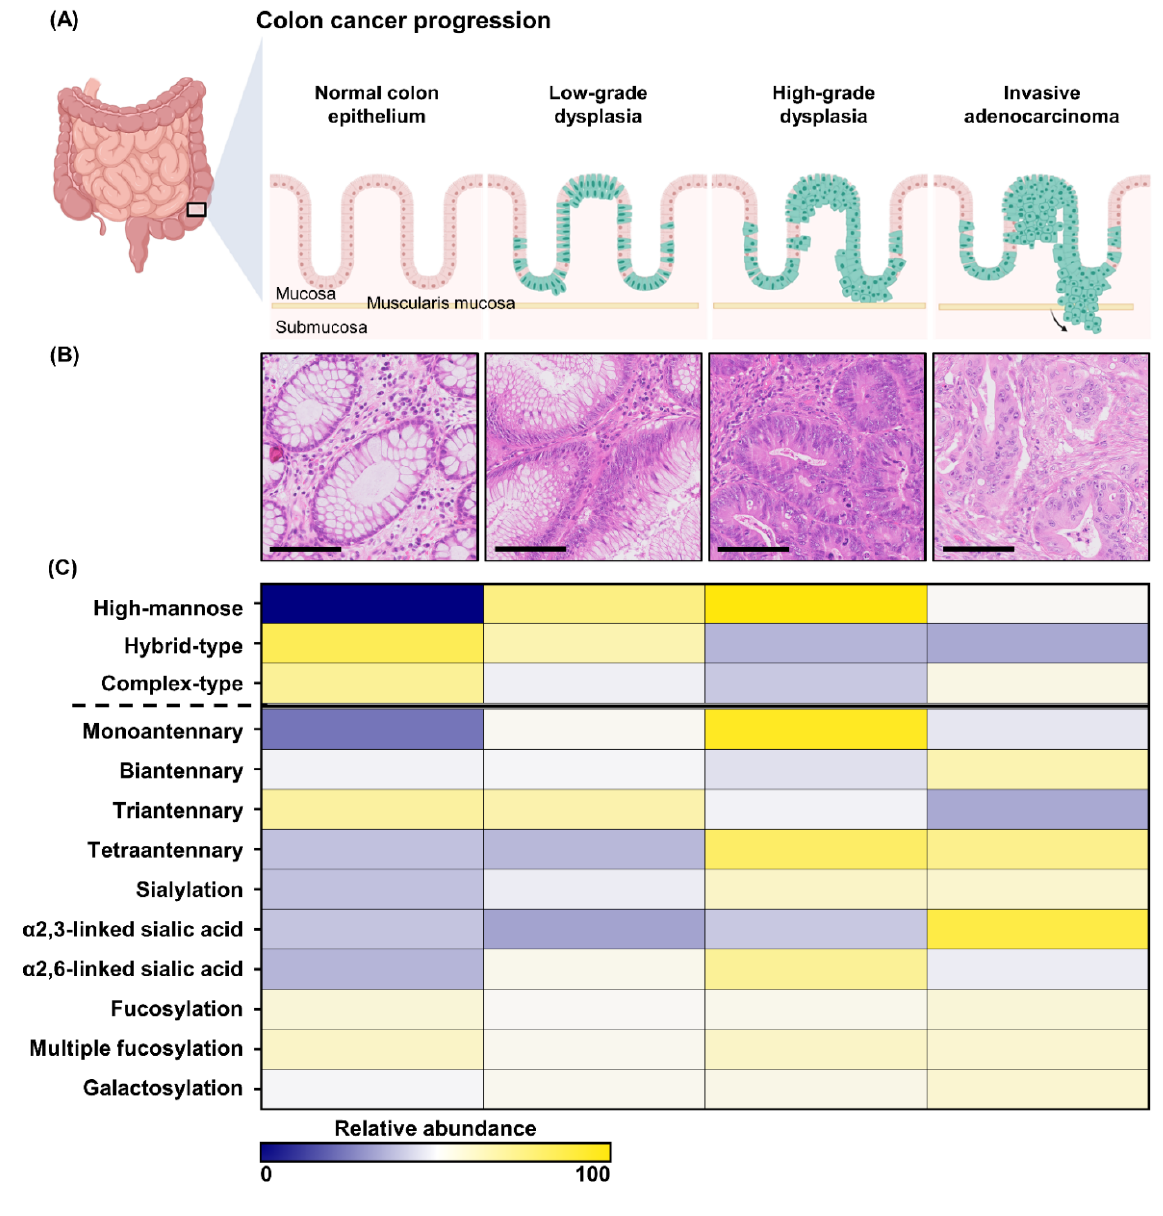
Figure 1 . Morphological and molecular progression of CRC. ( A ) A schematic representation of the morphological progression from normal colon epithelium to dysplasia and ultimately invasive carcinoma. ( B ) Examples of the different morphological stages of CRC development (40× magnification) using H&E stained tissues. The scale bars represent 100 µm. ( C ) The molecular progression of normal colon epithelium to CRC on the glycomic level. The glycome, shown here as different N -glycosylation traits, change throughout the progression to CRC.